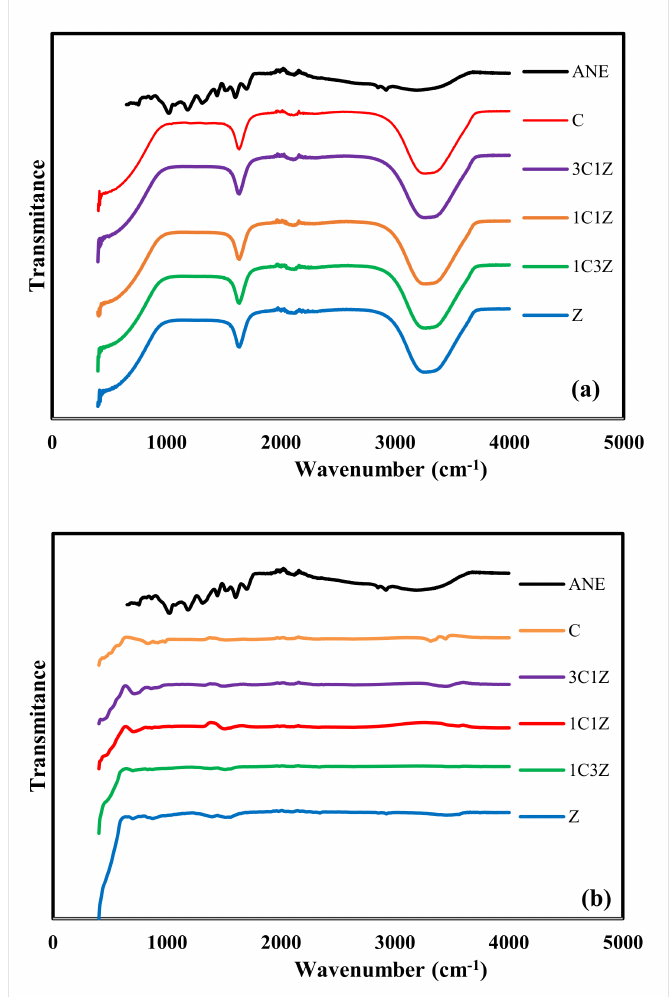
Figure 1. FTIR spectra of ANE, Z, 1C3Z, 1C1Z, 3C1Z, and C greenly prepared before ( a ) and after hydrothermal treatment (pH = 10, T = 250 ◦ C, t = 2.5 h) and calcination for 2 h at 300 ◦ C ( b ).